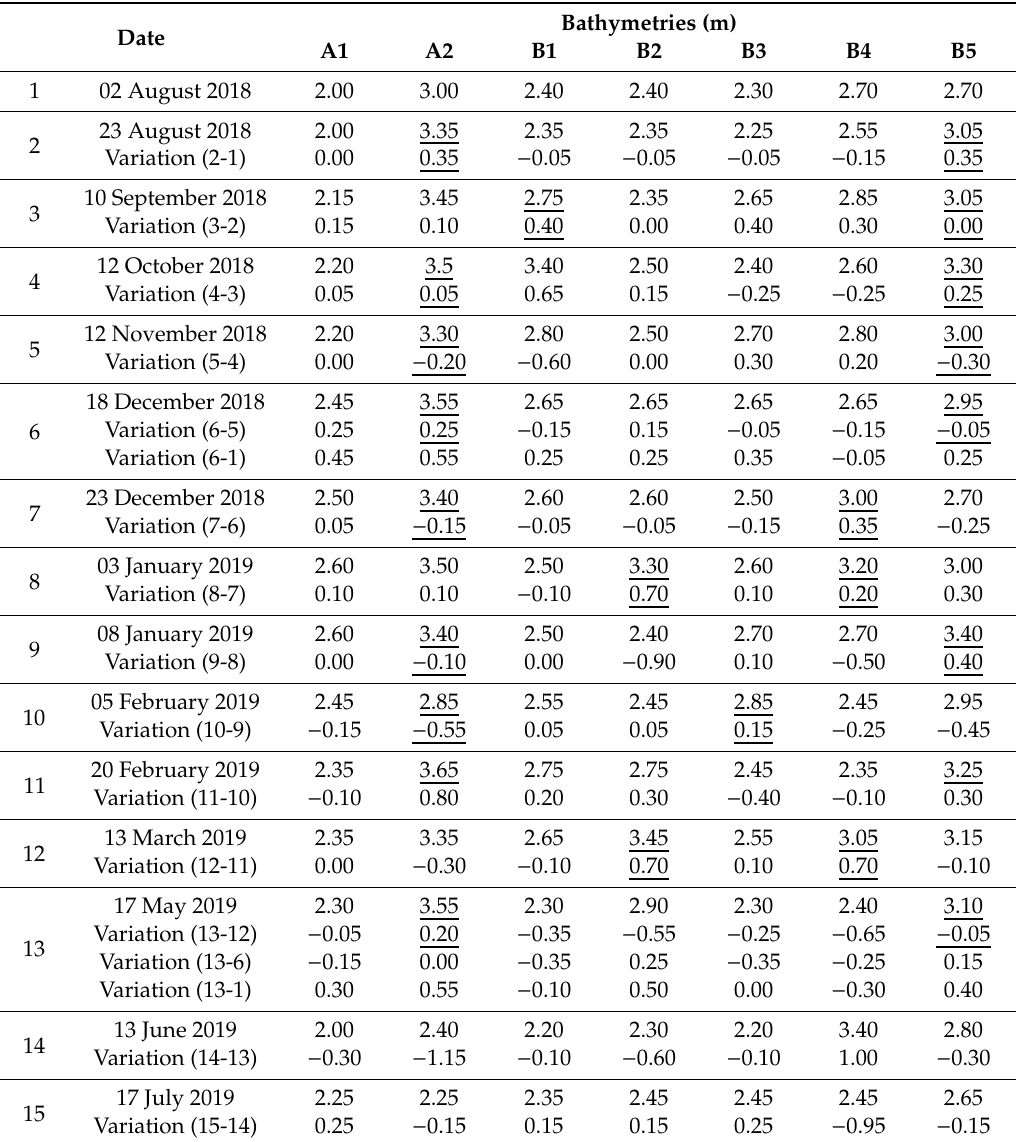
Table 6. Bathymetries measured in the timeframe from August 2018 to July 2019. The variation between two consecutive periods is reported, as well as the variation in relevant longer period. The underlined values are the ones measured wherein the ejectors were installed. The position A1 − A2 and B1 − B5 are the ones defined in Figure